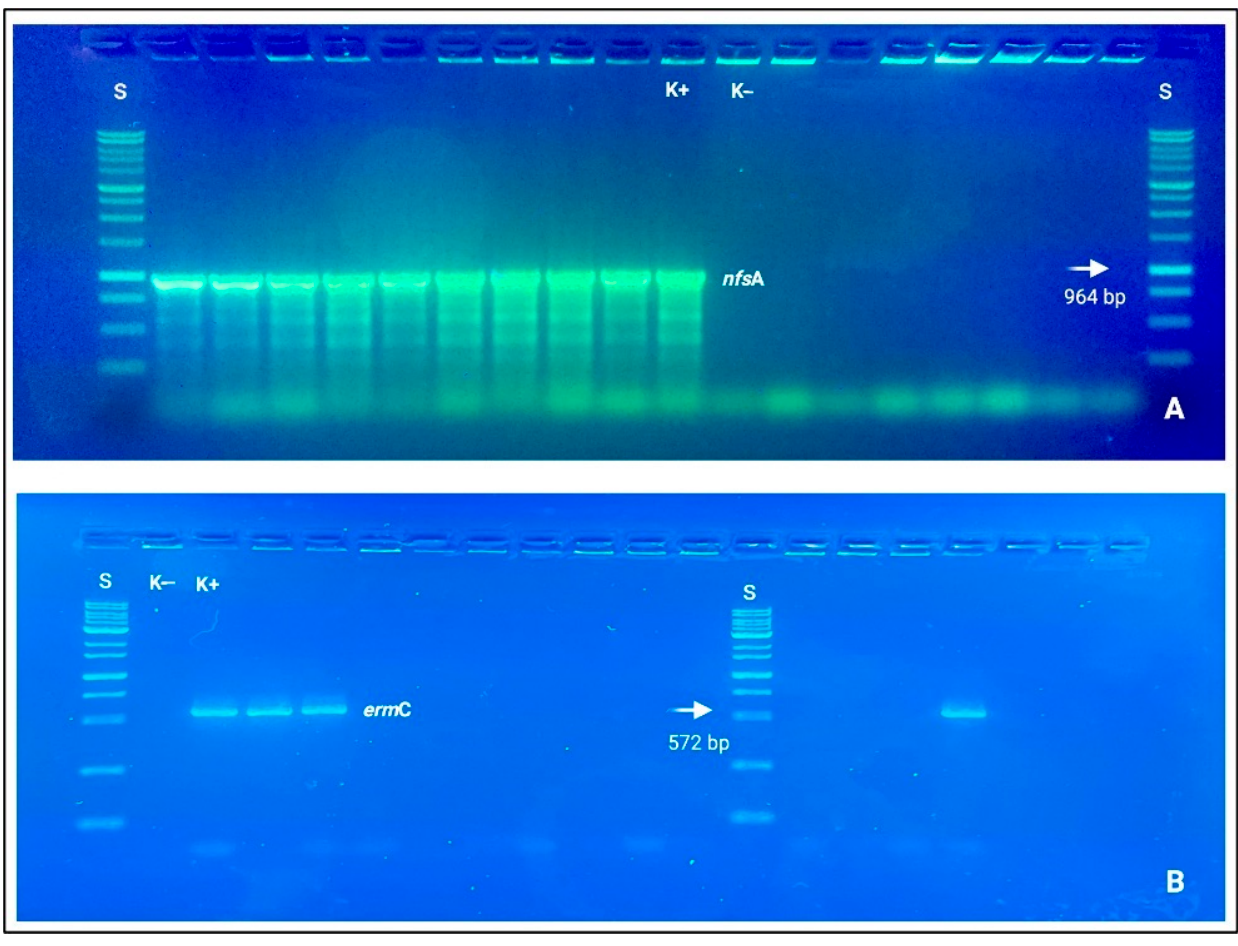
Figure 3. Electrophoresis gels (agarose 1.0%), in which it is possible to observe nitid positive ampli- cons and amplification results. ( A ) nfs A (964 bp); ( B ) erm C (572 bp). Loading wells: S: DNA ladder 1 Kb (Genetic ® FastGene 100–10,000 bp DNA Marker, Düren, Germany); K − : negative control and K+: positive control.